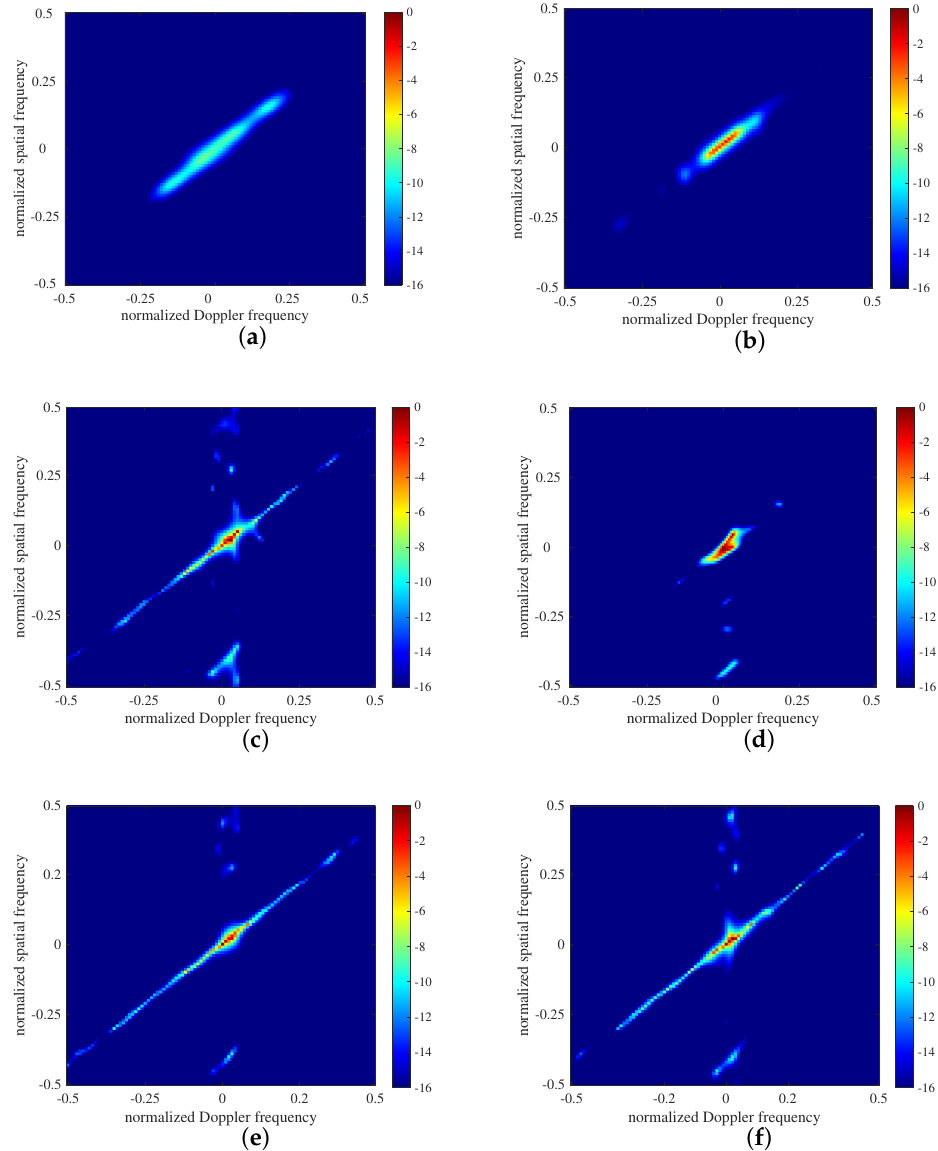
Figure 11. Estimated clutter spectrum of MCARM data. ( a ) LSMI. ( b ) M − OMP. ( c ) M − SBL. ( d ) M − FCSBL. ( e ) MCV. ( f )